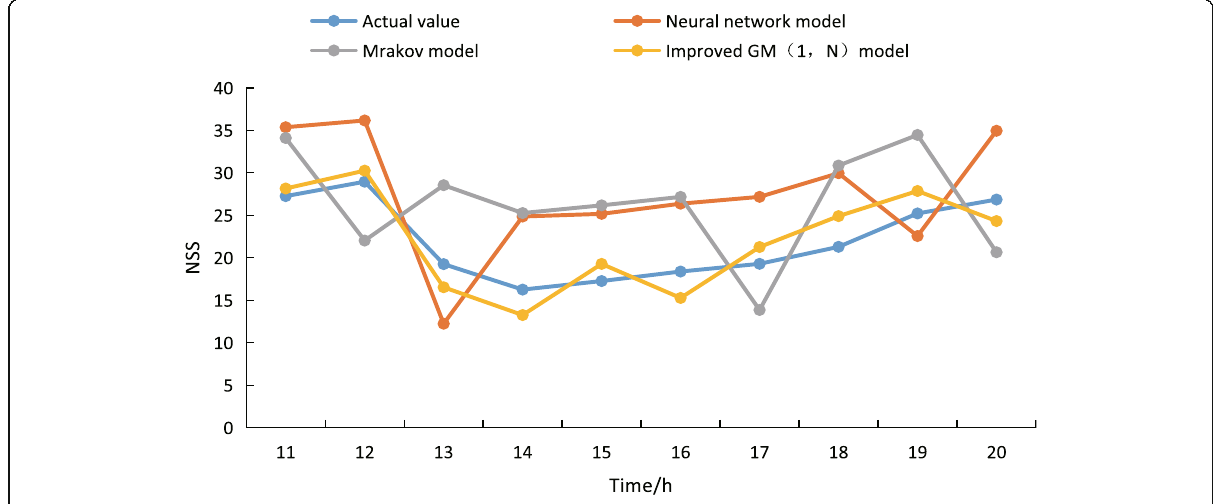
Fig. 2 The results of comparison with the other